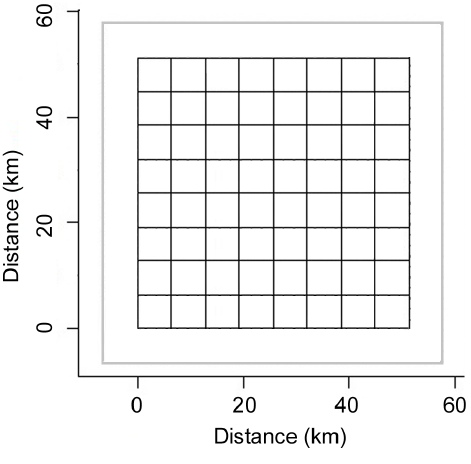
Figure 1. Schematic representation of study area. A representa- tion of the 2,264 km 2 study area, divided into a grid of 64 cells of 41 km 2 each, and set in the center of a 4,100 km 2 landscape, which is outlined in gray.